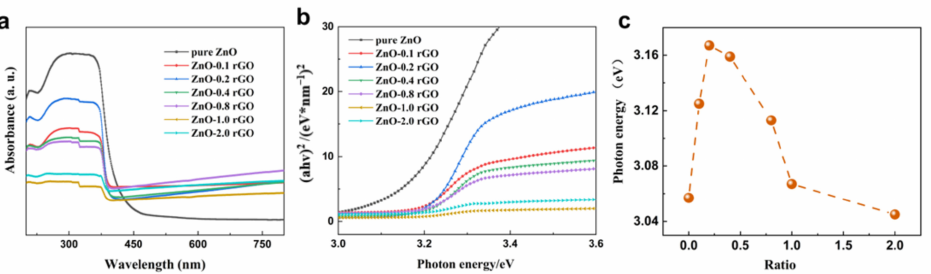
Figure 4. ( a ) UV-vis DRS spectra of ZnO-x rGO (x = 0, 0.1, 0.2, 0.4, 0.6, 0.8, 1.0, 2.0). ( b ) Graphical estimation of band gap; ( c ) Varation of band gap with addition of